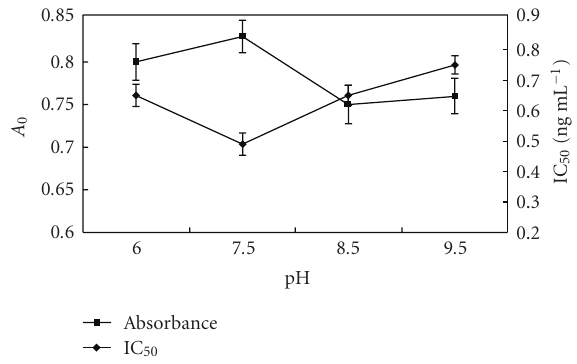
Figure 3: Optimization of pH of the diluting bu ff er ( n = 3).